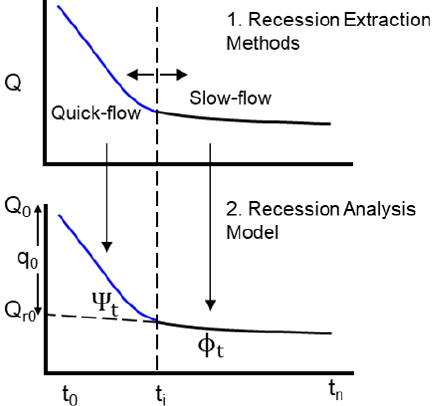
Figure 1. An illustration of the karst spring recession curve show- ing separation into linear and nonlinear components by the reces- sion extraction method and fitting appropriate components of the recession analysis